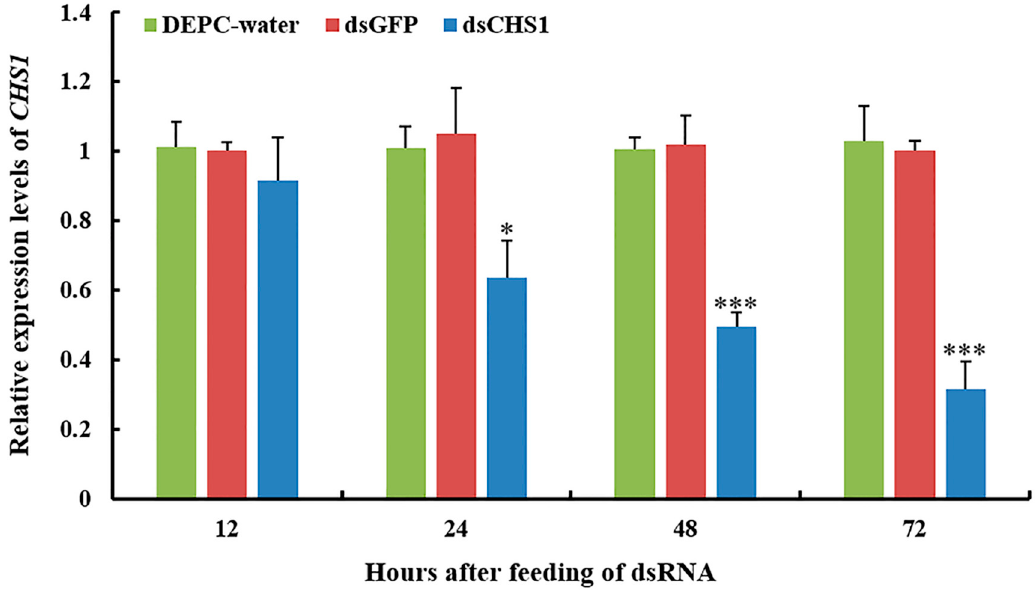
Figure 2. Gene silencing of CHS1 in A. gossypii fed an artificial diet with or without dsRNA- CHS1 . Relative abundance of CHS1 gene transcripts were determined as mean ( ± SE) of the three biological replicates, and thirty insects were used per pooled RNA sample with control as the calibrator, i.e., cDNA from non-RNAi aphids (only fed on artificial diet with DEPC-water and dsGFP). EF1 α and β -actin are used as the internal control. Treatments were compared using one-way ANOVA (Tukey’s HSD test, p < 0.05). * and *** represent p < 0.05 and p < 0.001, respectively.